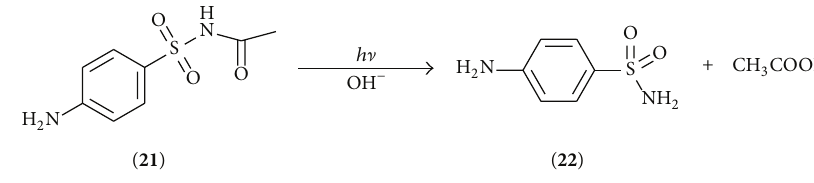
Figure 8: Photoinduced hydrolysis reaction of sulfacetamide.